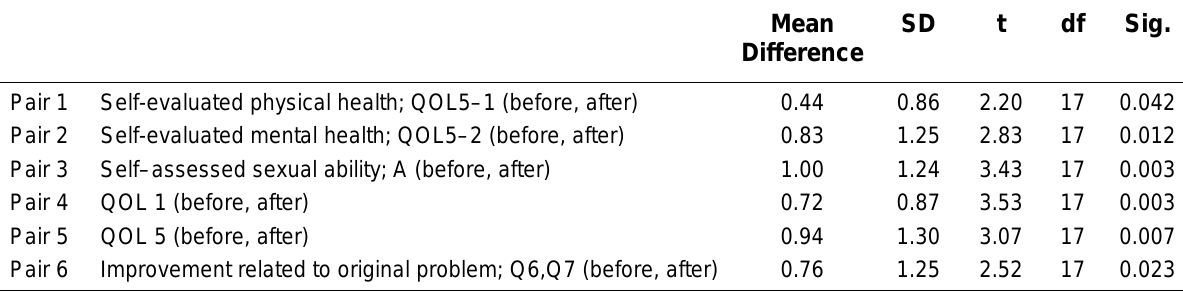
The Clinical Effect of VA (Paired Sample t-Test for the Whole Group, n = 18)